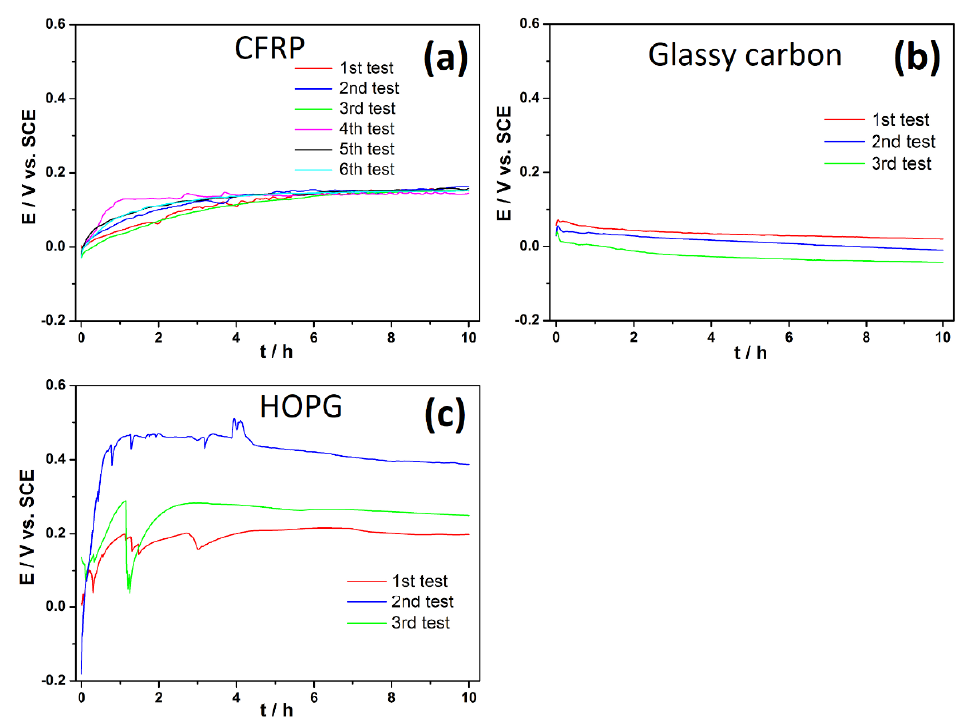
Figure 1. Open − circuit − potential profiles of ( a ) CFRP, ( b ) HOPG, and ( c ) glassy carbon in a 50 mM NaCl solution.